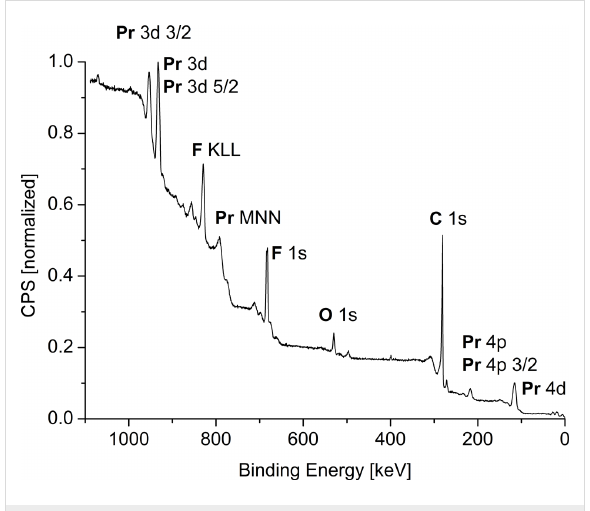
Figure 3: XPS of PrF 3 @TRGO-400 dispersions from [Pr(AMD) 3 ] in [BMIm][BF 4